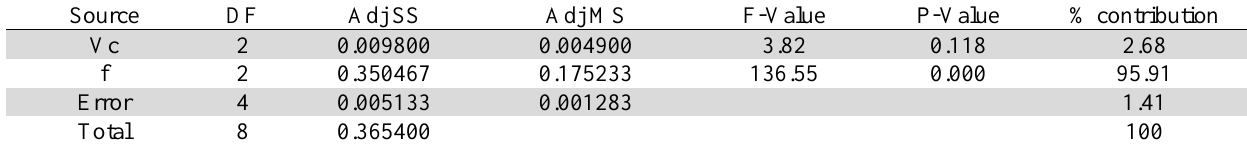
Analysis of variance for surface roughness (Ra)